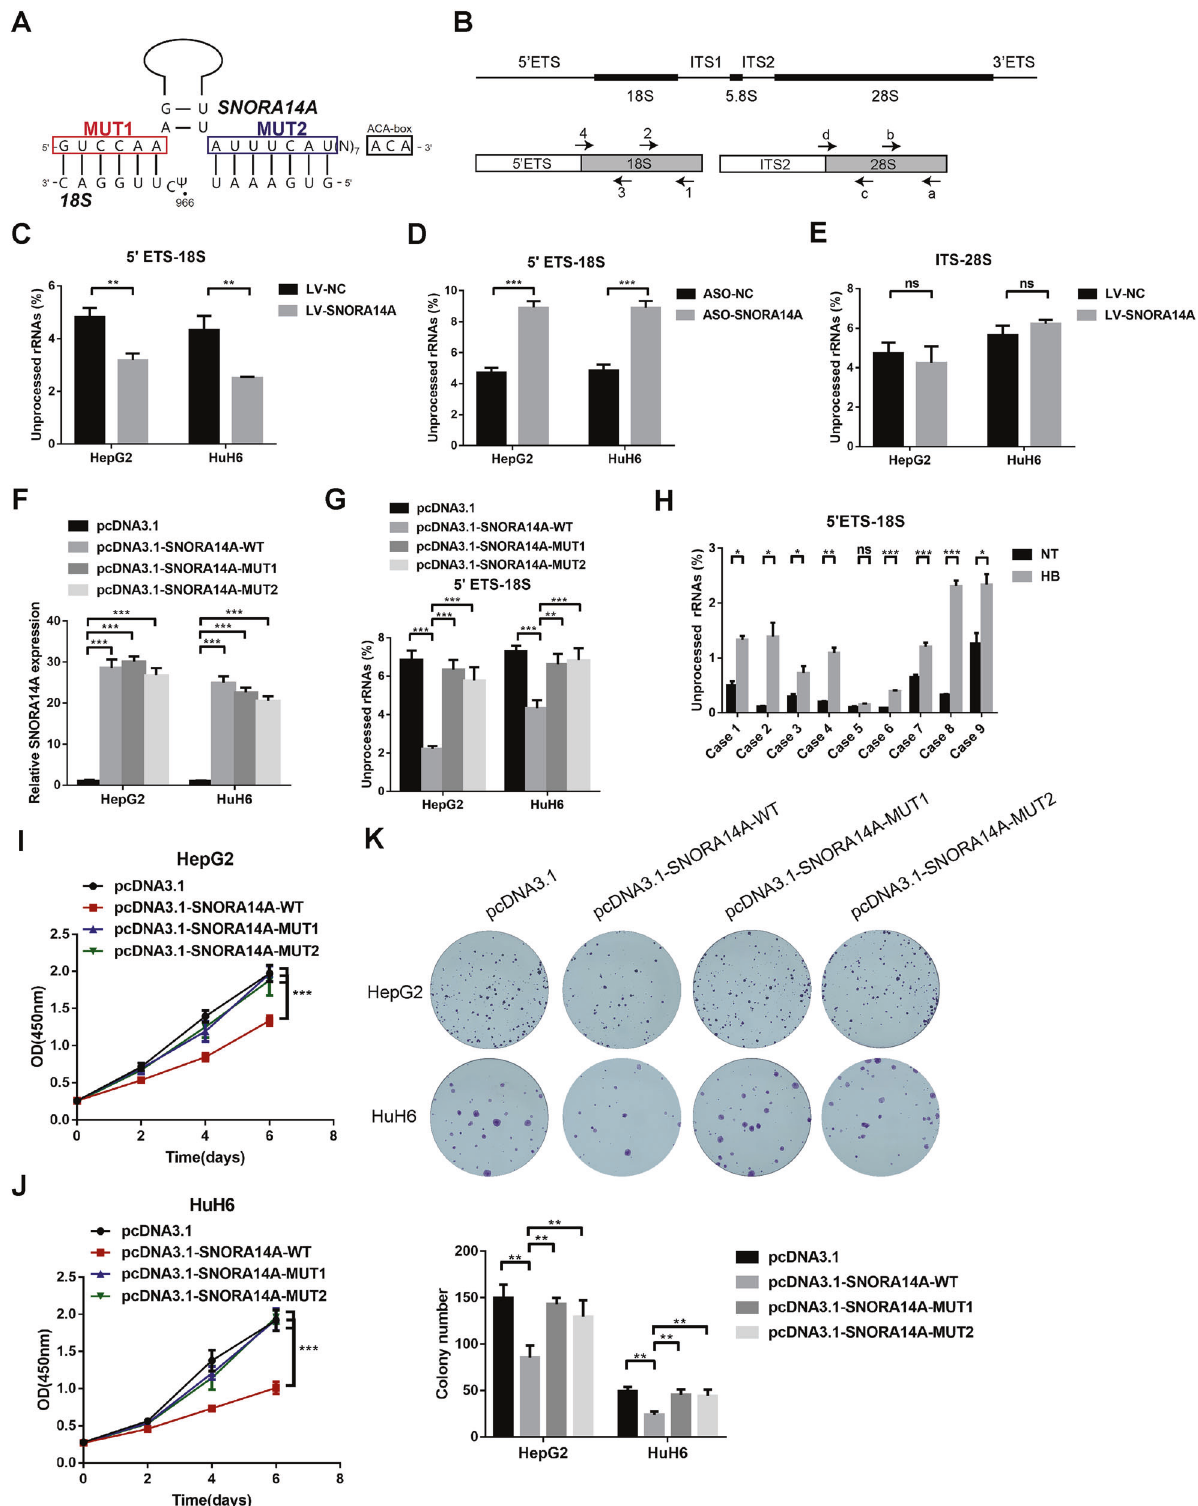
Fig. 4 SNORA14A interacts with 18 S rRNA to promote its maturation and inhibit HB cell proliferation. A The interaction site between SNORA14A and 18 S rRNA and construction of SNORA14A-mutant vectors. B Top: schematic diagram of the eukaryotic rRNA precursor. Bottom: speci fi c primers for total 18 S rRNA (primer pair 1/2), 18 S rRNA precursor (primer pair 3/4), total 28 S rRNA (primer pair a/b) and 28 S rRNA precursor (primer pair c/d). C , D The percentage of unprocessed 18 S rRNA in HB/LV-NC and HB/LV-SNORA14A cells ( C ) or cells transfected with ASO-NC or ASO-SNORA14A ( D ) was measured by qRT ‒ PCR. E The percentage of unprocessed 28 S rRNA in HB/LV-NC and HB/ LV-SNORA14A cells was measured by qRT ‒ PCR. F , G Relative expression levels of SNORA14A ( F ) and unprocessed 18 S rRNA ( G ) in treated HB cells were measured by qRT ‒ PCR. H The percentage of unprocessed 18 S rRNA in 9 pairs of HB and NT tissues was measured by qRT ‒ PCR. I – K The proliferative activity of treated HB cells was detected by CCK-8 ( I , J ) and colony formation ( K ) assays. Cell Death Discovery (2023)